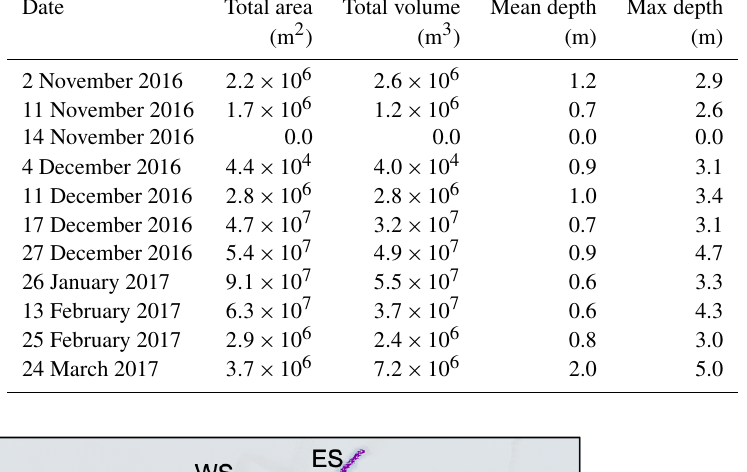
Table 1. Total area, total volume, and mean depth of all meltwater bodies on the Nivlisen Ice Shelf on various dates in the 2016–2017 melt season.